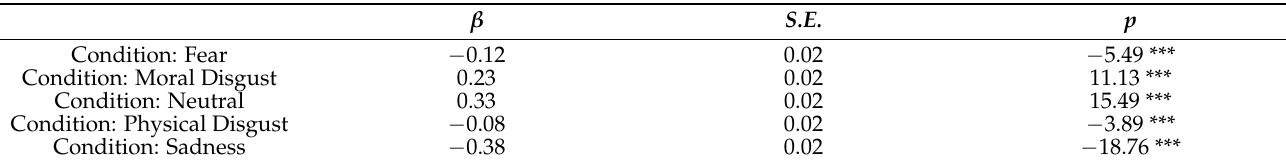
Table 8. Results of the LMM, conducted in Experiment 2. Analyses conducted on the individual probability discount rates (log h) using the fixed effects of the condition (Ager, Moral disgust, Physical Disgust,